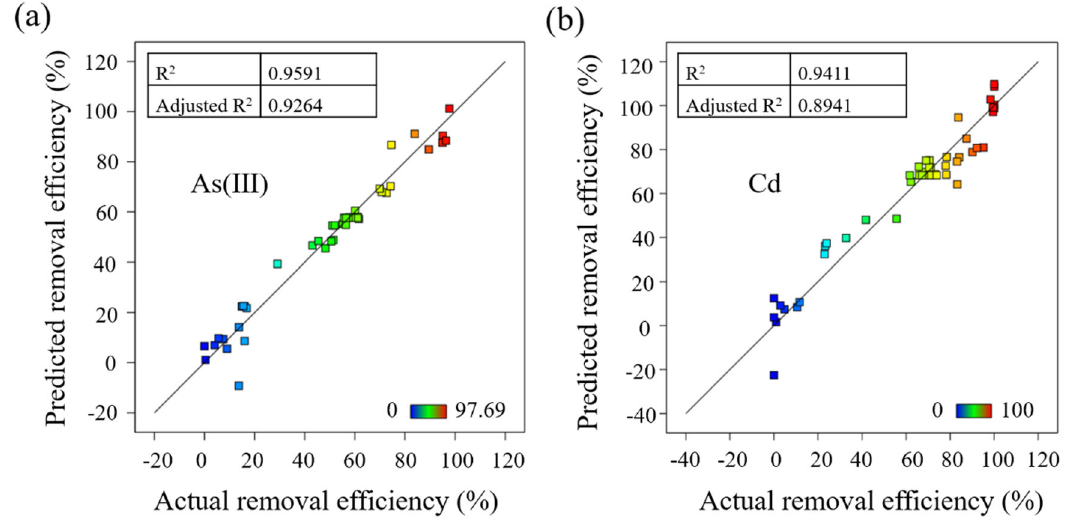
Fig. 4 Actual and predicted As(III) and Cd removal ef fi ciencies. ( a ) As(III) and ( b ) Cd. Points are colored by the values of As(III) and Cd actual removal ef fi